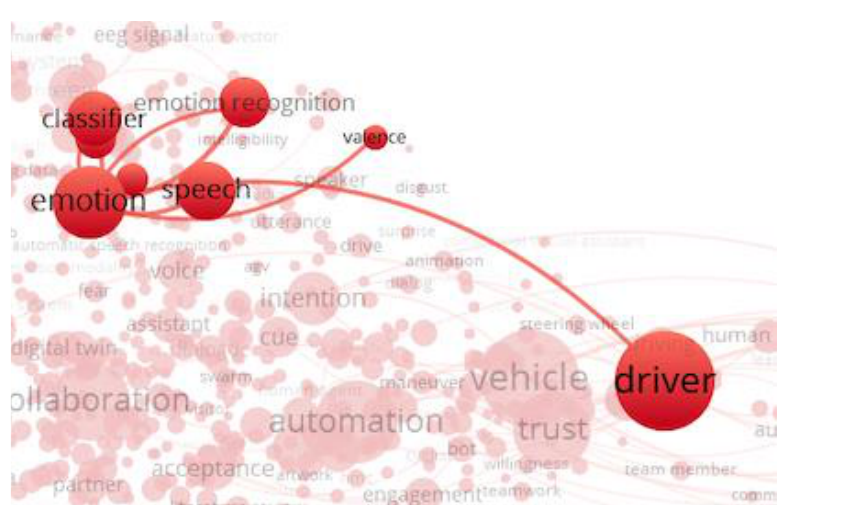
Figure 14. Driver dependency.